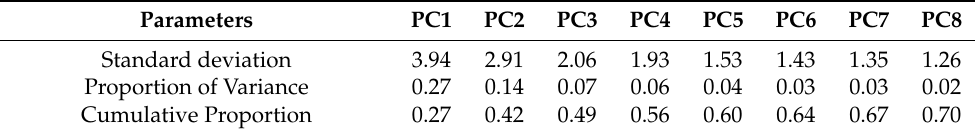
Figure 1. Screeplot of best teams. Table 2. Components and total variance